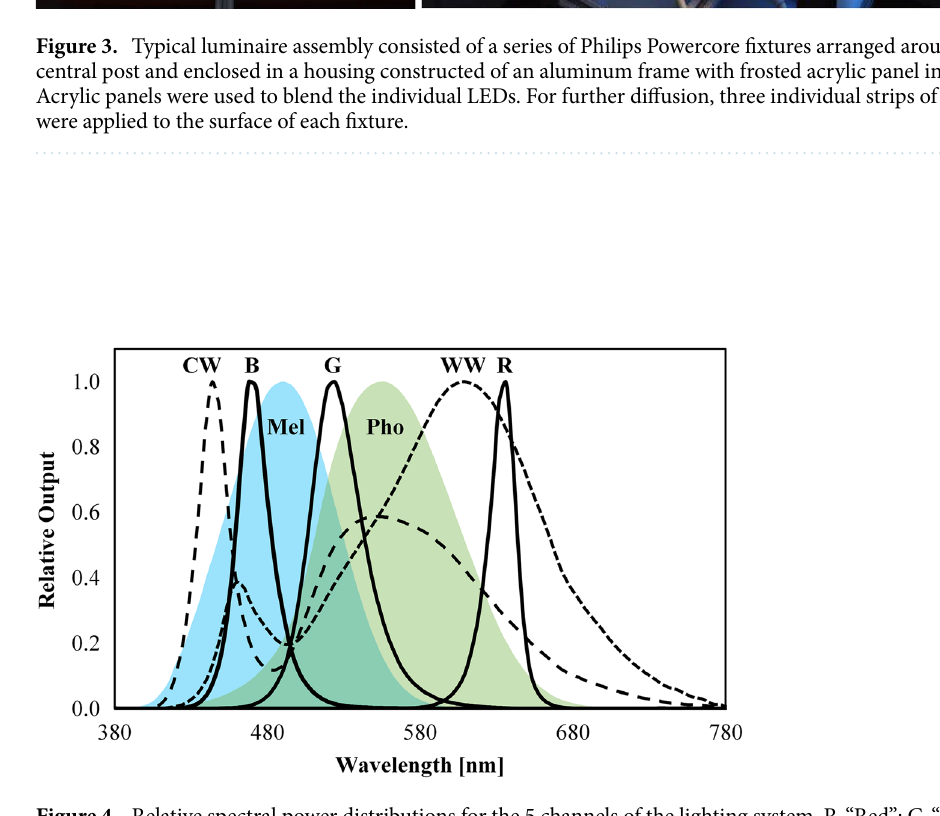
Figure 4. Relative spectral power distributions for the 5 channels of the lighting system. R, “Red”; G, “Green”; B, “Blue”; WW, “Warm White”; CW, “Cool White”; Pho, photopic Luminous Efficacy Function and Mel , melanopsin action